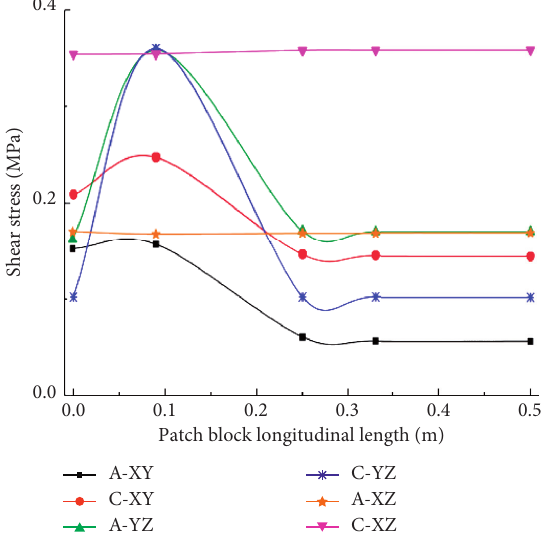
Figure 11: The effects of longitudinal movement of different loading positions on shear stress of leveling layer. Table 2: Shear stress value at C1 loading